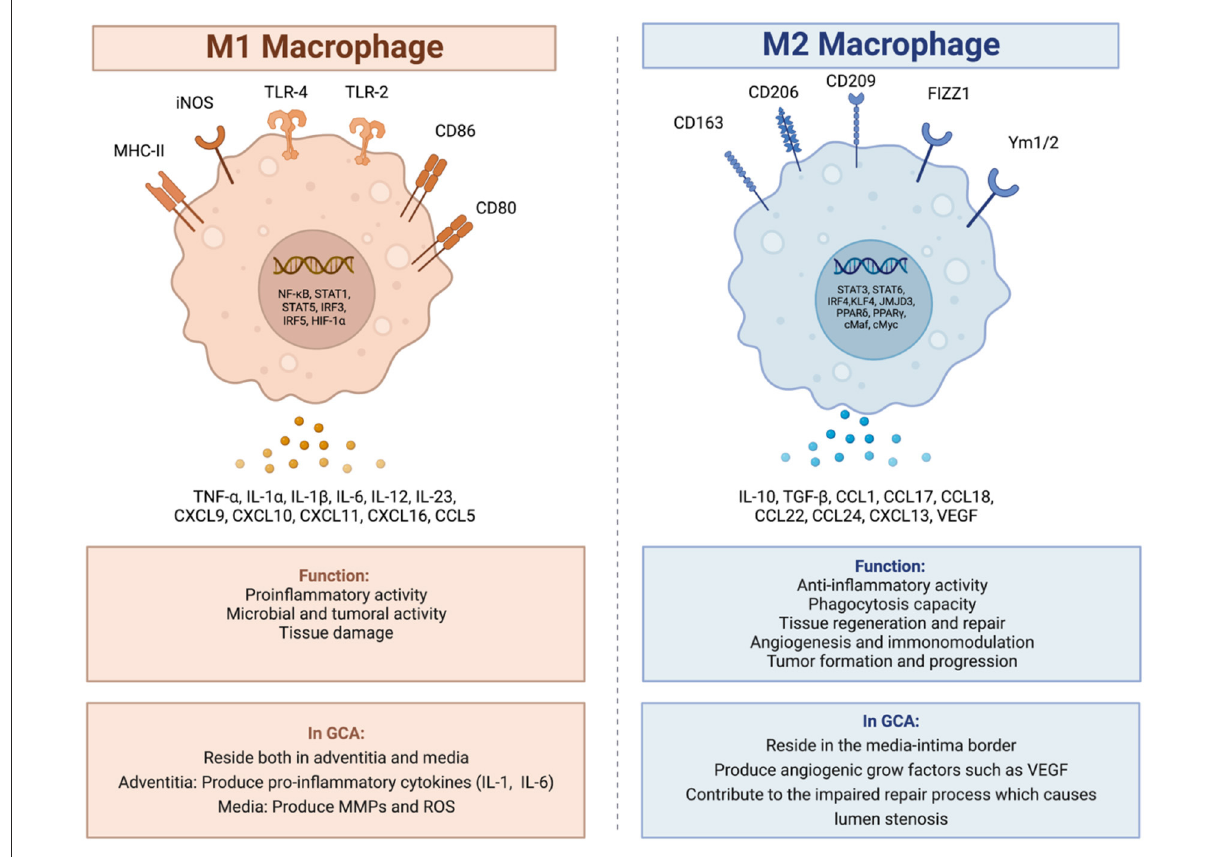
FIGURE1 M1 and M2 macrophages, and their role in giant cell arteritis. In GCA there are two main types of macrophages. The M1 macrophages specialized in proinflammatory and tissue destructive actions and the M2 macrophages specialized in tissue repair mechanisms. Created with BioRender.com. Adapted from “Macrophage polarization: M1 and M2 subtypes”. Retrieved from https://app.Biorender.com/biorender-